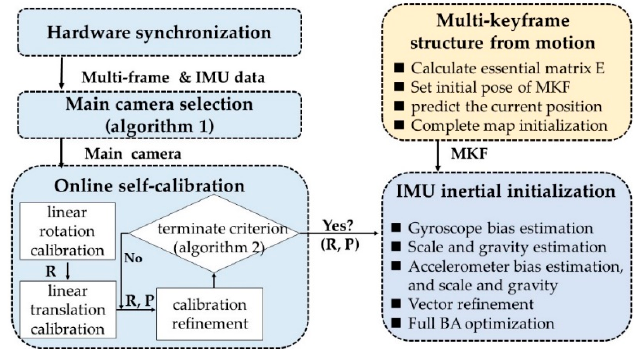
Figure 3. The procedure of visual-inertial initialization. The initialization includes two pre-requires: Hardware synchronization mechanism and online self-calibration. Following the multi-keyframe structure from motion and IMU inertial initialization.